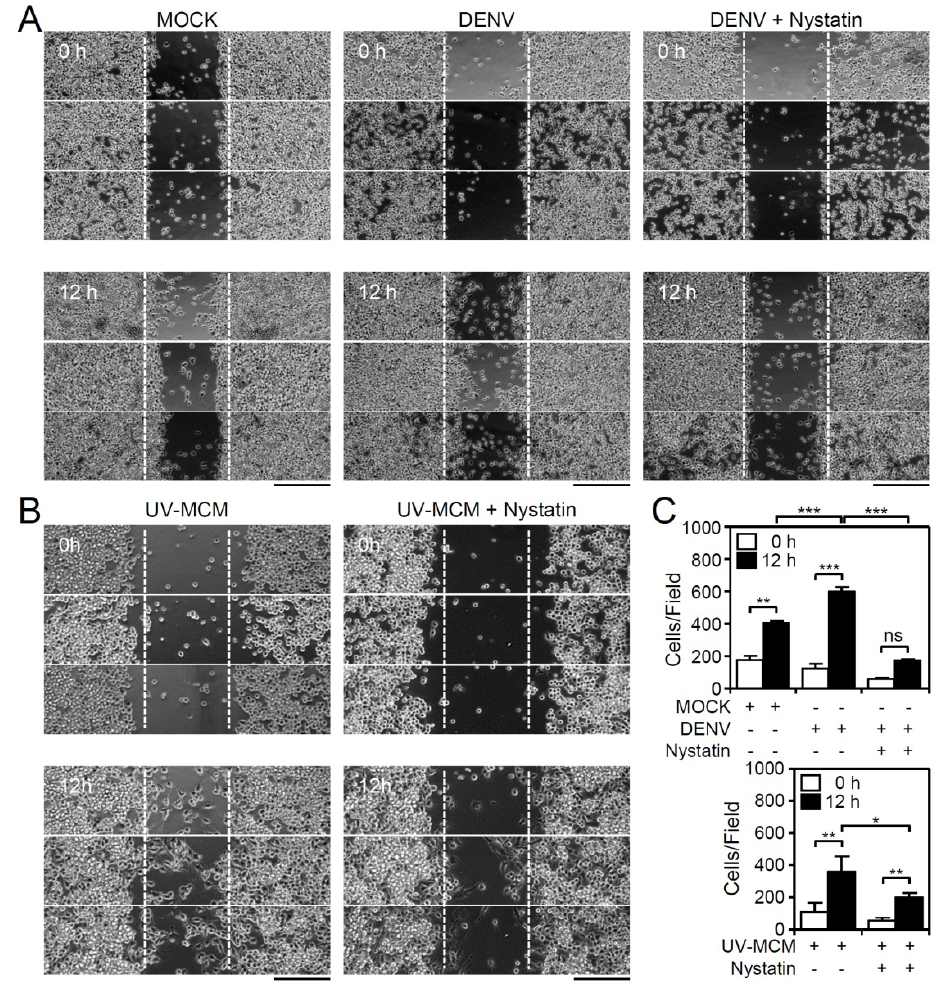
Figure 2. Inhibition of lipid rafts/caveolae retards DENV-induced BV2 microglial cell migration. Migration in DENV- and UV-MCM-stimulated BV2 cells incubated with or without lipid rafts/caveolae inhibitor (Nystatin, 5 µ M) treatment was measured by the wound-healing assay 12 h post-infection. ( A , B ) The wound-healing assay and ( C ) the measurement of the migrating cell number showed cell migration. Scale bar, 200 µ m. All quantitative data are shown as the means ± SD from three independent experiments. * p < 0.05, ** p < 0.01, and *** p < 0.001. ns, not significant.